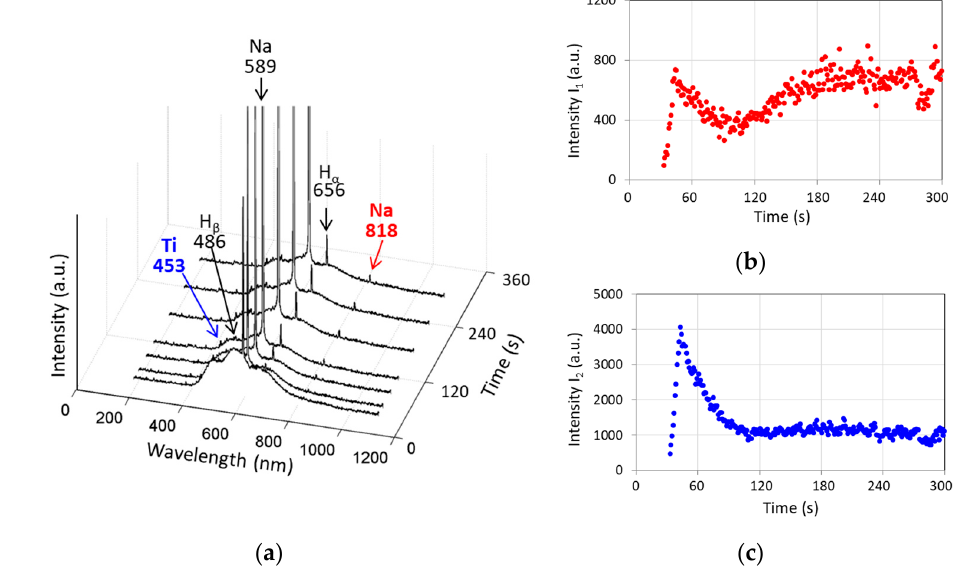
Figure 6. Optical emission spectra of microdischarges during the PEO of Ti: ( a ) overview of the optical emission spectra evolution; ( b ) intensity I 1 for Na II (817.986 nm) representing the component of the electrolyte; ( c ) intensity I 2 for Ti I (453.501 nm) representing the substrate.